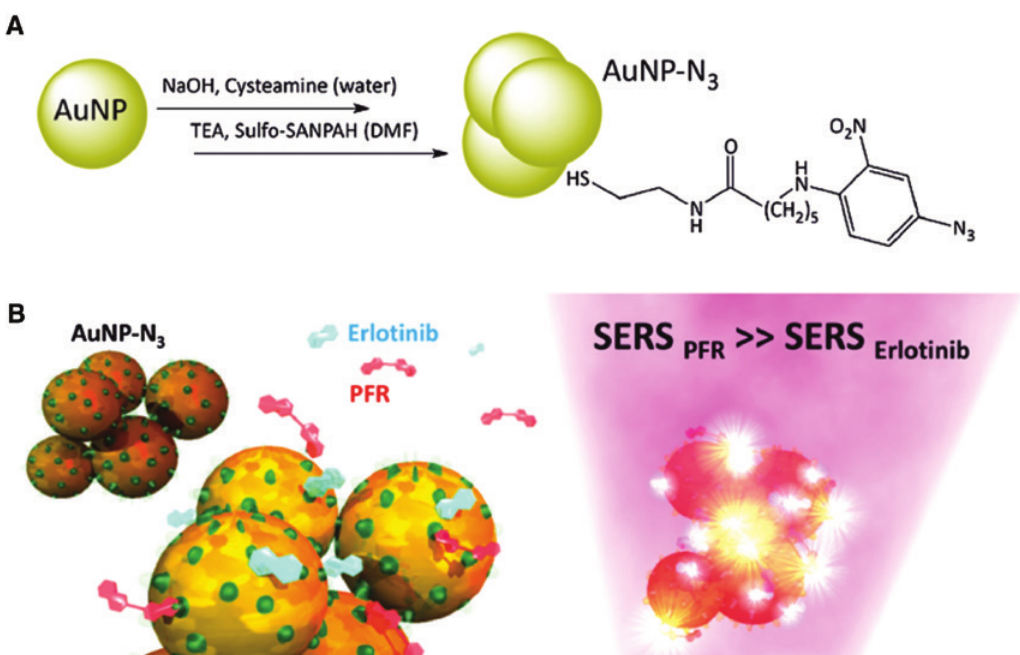
Figure 5: Schematic illustration of the production and application of a SERS substrate modified to avoid the protein problem. (A) Fabrication of the graphene oxide (GO)-supported functionalized starlike gold nanoparticles. L-cysteine is used to functionalize the NPs. (B) The L-cystein monolayer acts as brush layer and prevents blood serum proteins from blocking the SERS hot spots. Adapted from Panikar et al. [84], reproduced with the kind permission of the American Chemical Society, Copyright (2019) American Chemical Society.